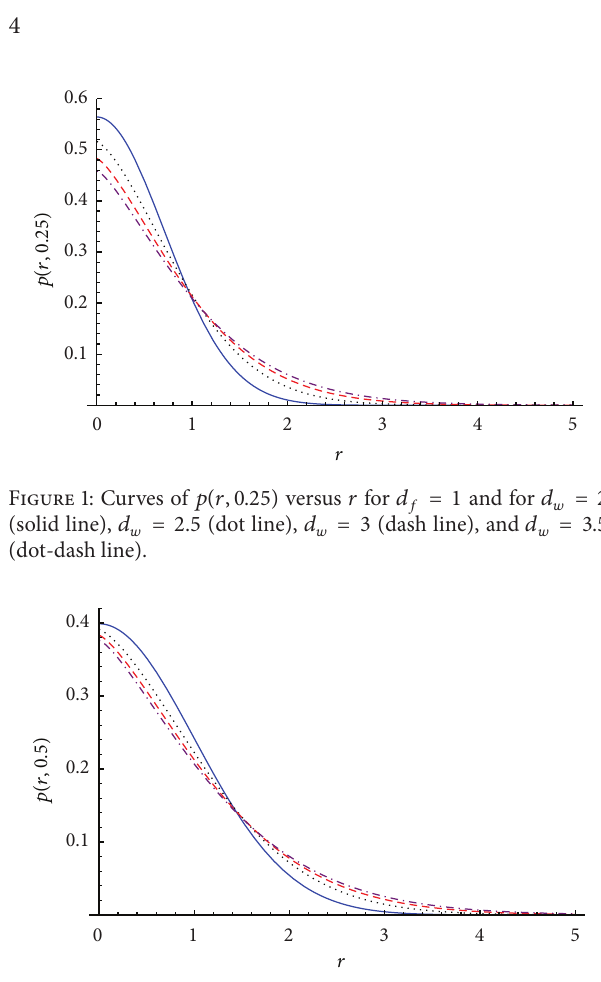
Figure 4: Curves of 𝑝(𝑟,0.5) versus 𝑟 for 𝑑 𝑓 = 1.5 and for 𝑑 𝑤 = 2 (solid line), 𝑑 𝑤 = 2.5 (dot line), 𝑑 𝑤 = 3 (dash line), and 𝑑 𝑤 = 3.5 (dot-dash